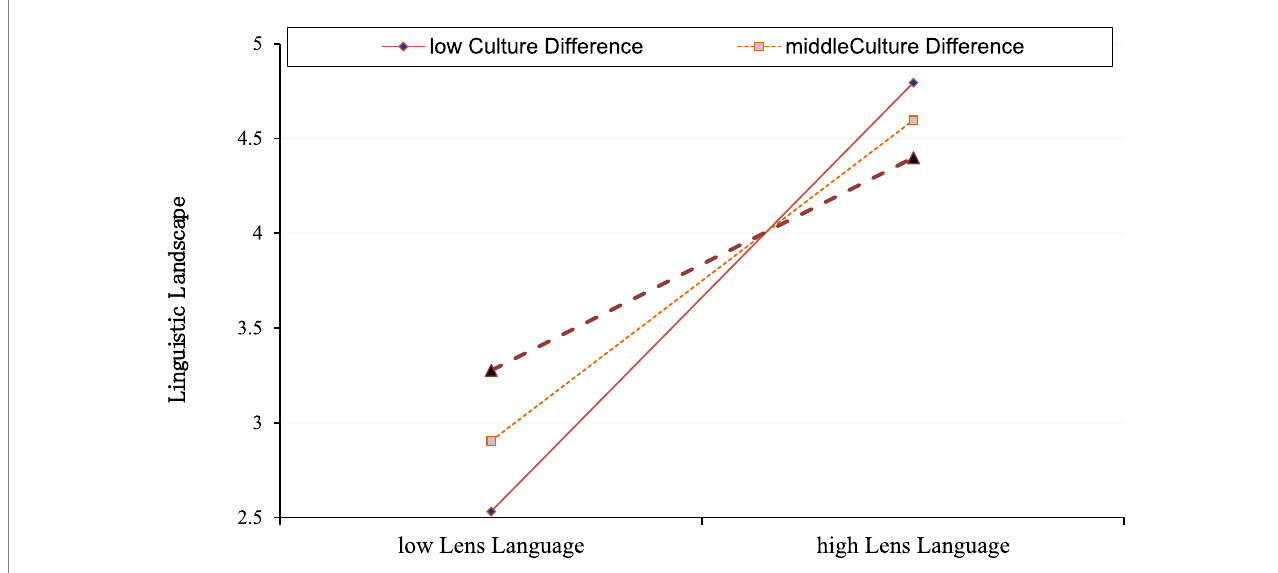
FIGURE 4 Culture difference as a moderating variable between tourism linguistic landscape and lens